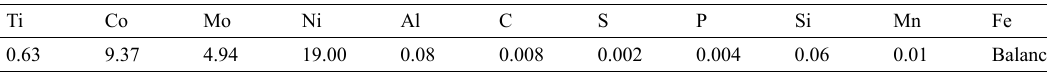
Table 1. Chemical composition (wt. %) of the maraging 300 18 .